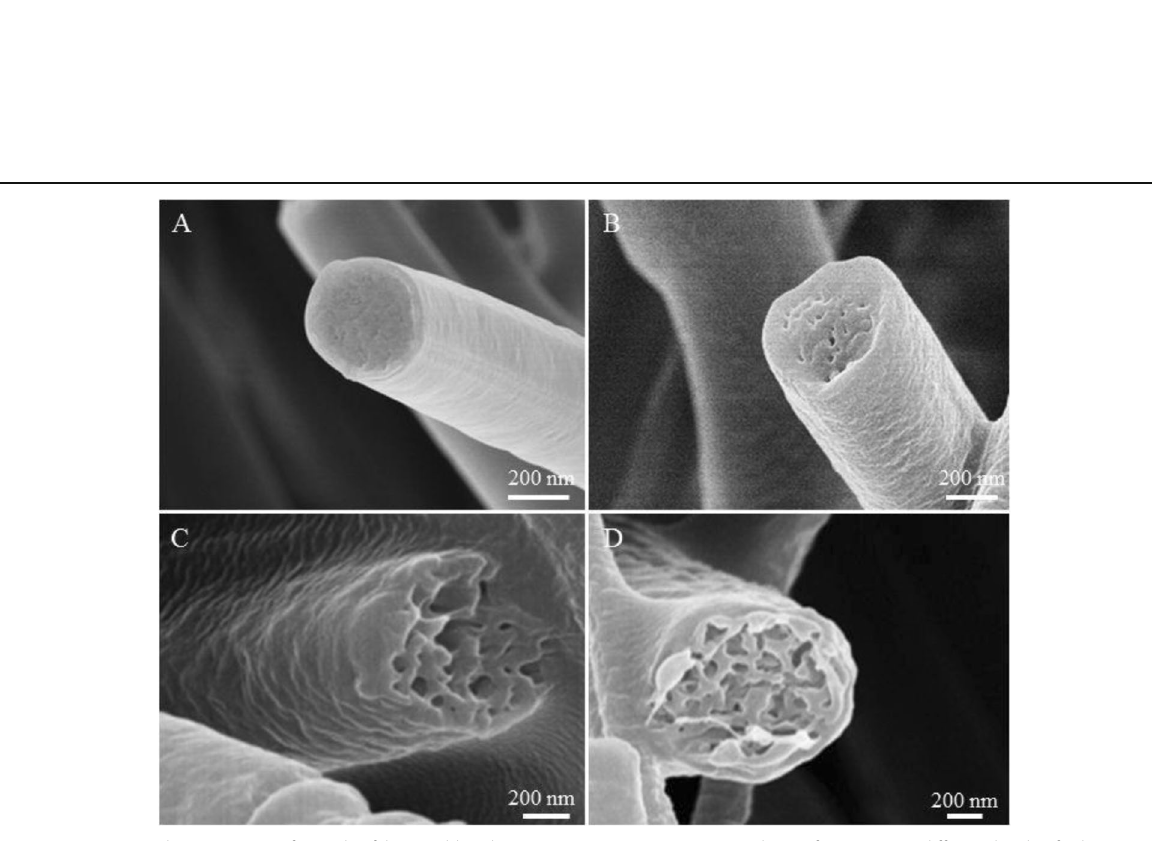
Fig. 5 Cross-sectional SEM images of samples fabricated by electrospinning 35% ( w / v ) PVDF solution from DMF at different levels of relative humidity. a 5%, b 25%, c 45%, and d